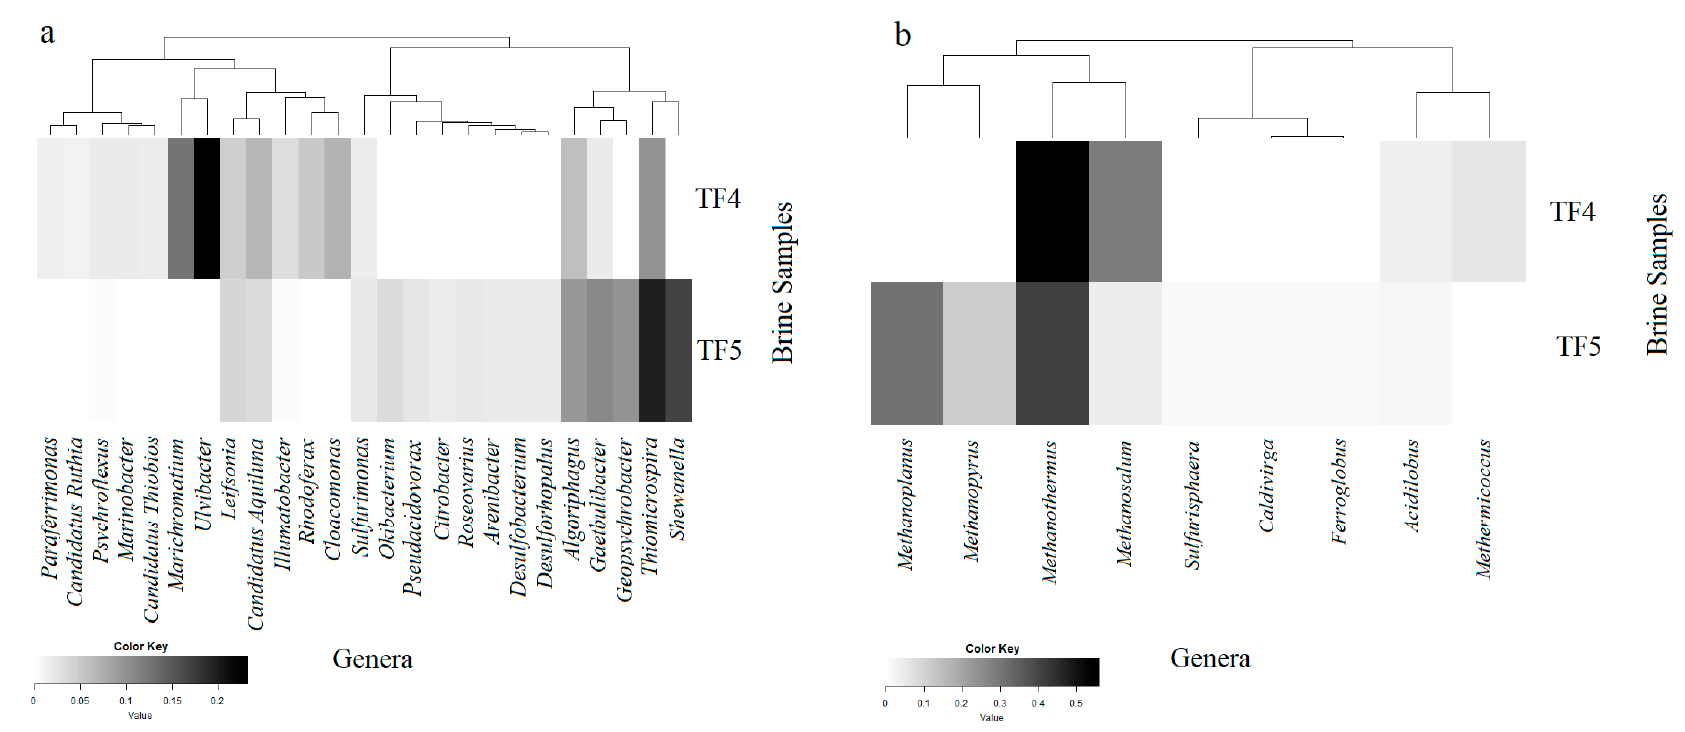
Figure 5. Heatmaps of presence and abundance of bacterial ( a ) and archaeal ( b ) genera in the brine samples. Color blocks represent the relative abundance of genera. More darkness indicates a higher relative abundance.